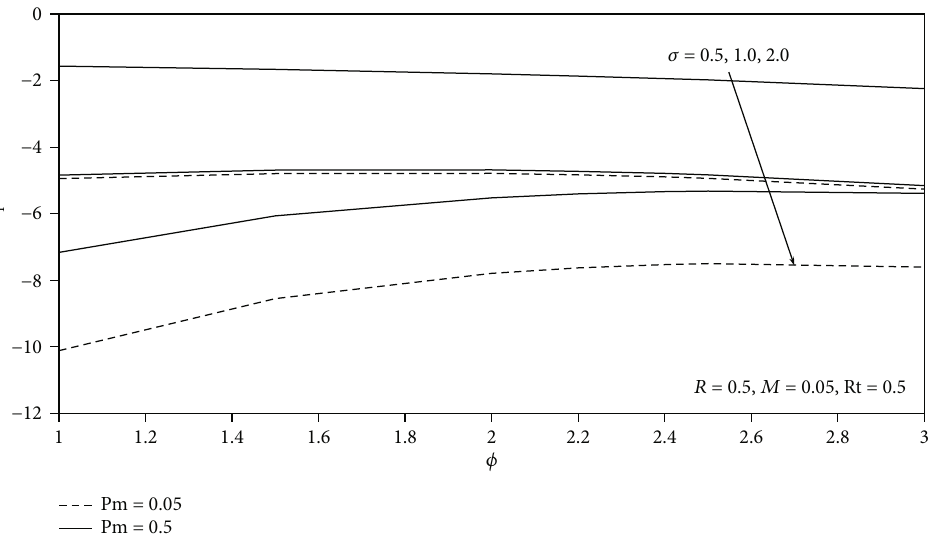
Figure 16: Variation of skin friction ð s